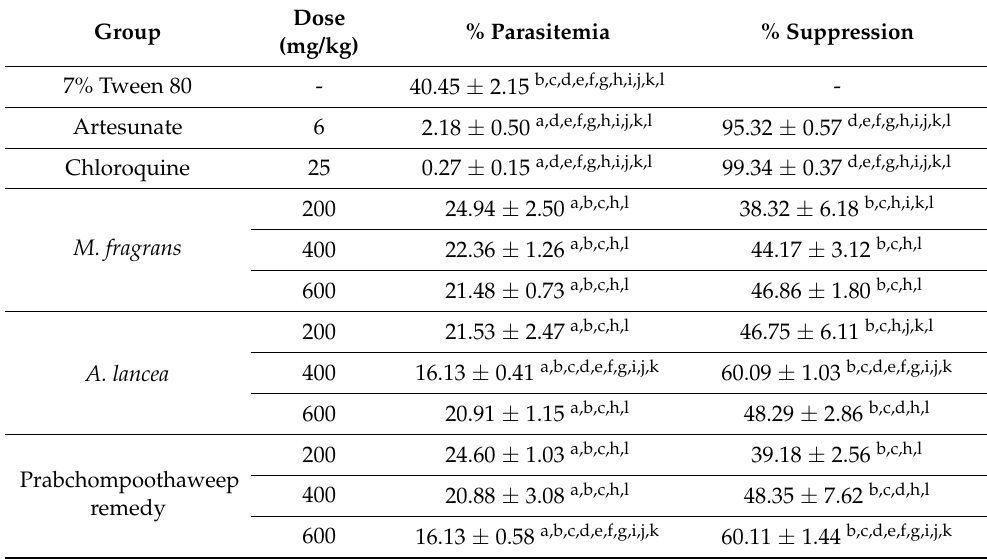
Table 5. Effect of ethanolic extracts of M. fragrans , A. lancea , and Prabchompoothaweep remedy on parasite level and parasite suppression in the 4-day suppressive test.